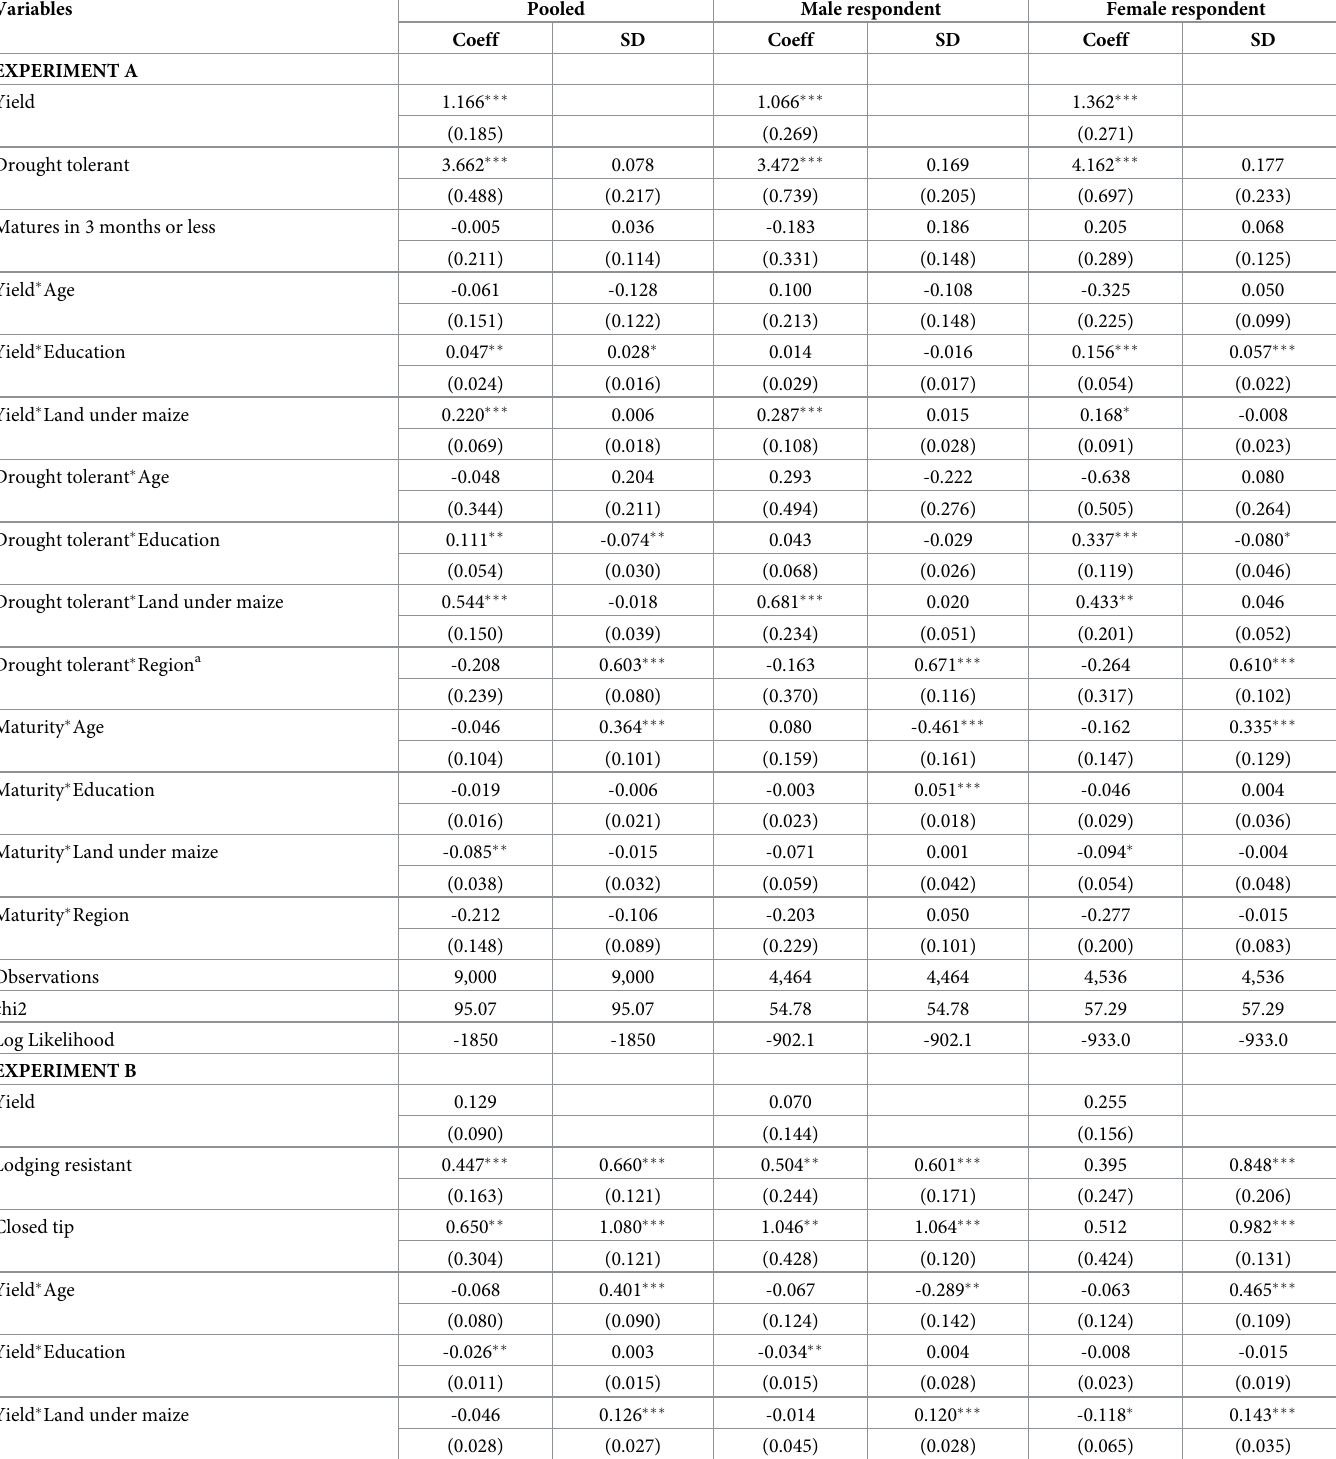
Table 5. Mixed logit results for Ethiopia with interaction terms: Experiment A (drought tolerance, maturity in three months or less) B (lodging resistant, closed tip) and C (sweet taste and resistant to foliar